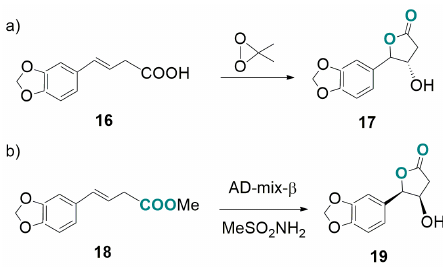
Scheme 14. Conversion of styrylacetic acids into γ‐